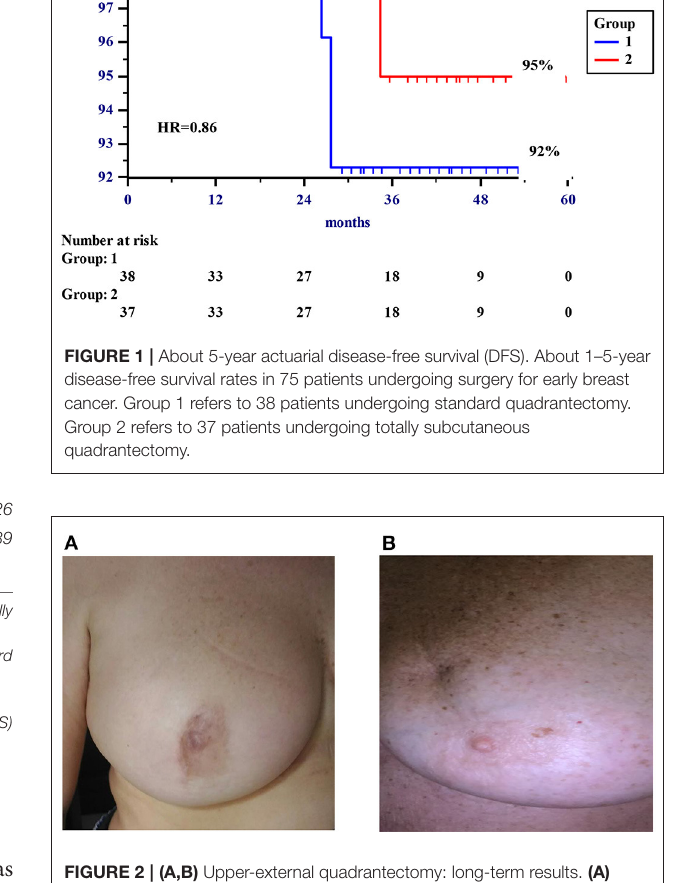
FIGURE 2 | (A,B) Upper-external quadrantectomy: long-term results. (A) totally subcutaneous quadrantectomy (TSQ): The scar is near the areola with minimal alteration of the breast shape. (B) standard quadrantectomy (SQ): The scar is into the quadrant with minimal retraction in the middle